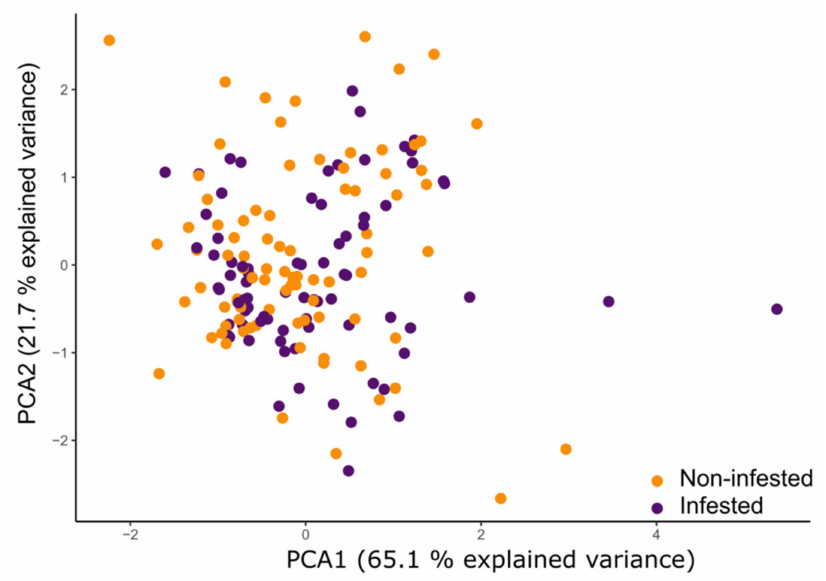
Figure 3. Scatter plot of the first two principal components. The dots are colour-coded to plant infestation status. Although the first two PCA components explain more than 86% variance, no particular patterns can be observed. Table 4. sPLS-SVM classification results of pooled data from all three imaging sessions (days 14, 21 and 28). Treatment labels are defined in Table 1.